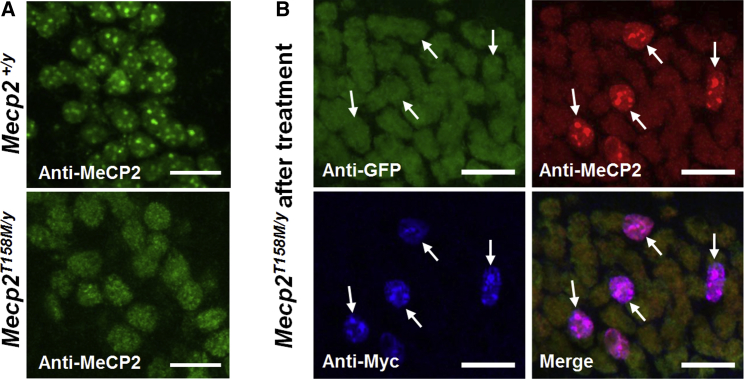
Nuclear Localization of MeCP2 in Untreated and Treated Mecp2T158M/Y MiceRepresentative confocal images of the CA1 region of the hippocampus. (A) Endogenous MeCP2 exhibits heterochromatin-enriched localization in WT nuclei, while GFP-tagged MeCP2 exhibits decreased heterochromatin localization (i.e., more diffuse labeling) in nuclei from Mecp2T158M/y mice. (B) Images demonstrating heterochromatin-enriched localization of vector-derived MeCP2 in nuclei of transduced cells in Mecp2T158M/y mice treated with the first-generation vector. White arrows indicate transduced cells (Myc-positive). Scale bars indicate 20 μm.